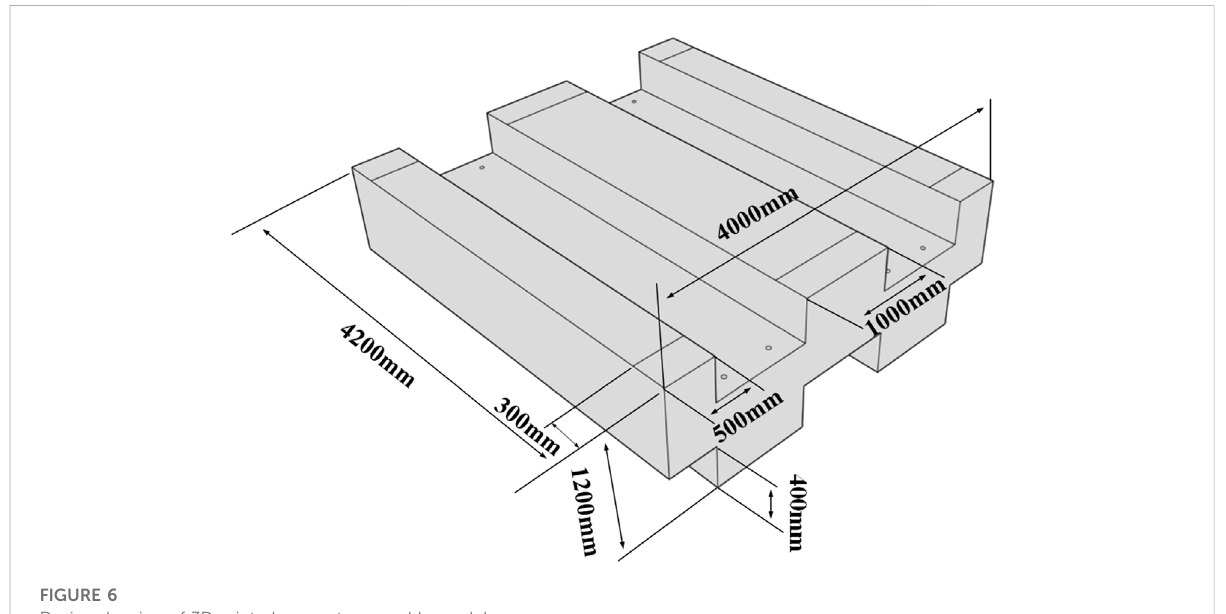
FIGURE 6 Design drawing of 3D printed concrete assembly module.